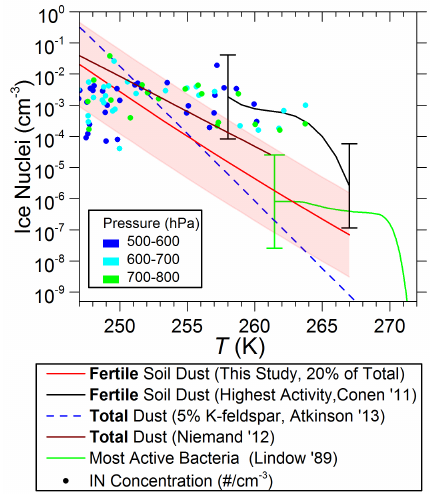
Fig. 9. The concentration of immersion mode IN based on mod- elled global mean aerosol concentrations and laboratory-derived ice nucleation efficiencies. Calculation of the IN concentrations is de- tailed in Sect. 4. Aerosol concentrations are taken from Hoose et al. (2010b) at 600hPa, vertical bars represent the range of zonal annual mean particle number concentrations (Hoose et al., 2010b; Murray et al., 2012). For the fertile soil dust IN concentrations (this study and Conen, 2011) it was assumed that the fertile soil dust loading is equivalent to 20% of the total dust emissions; for the bac- teria it was assumed that 1 / 100 airborne bacteria were as efficient as the most active bacterial ice nuclei from Lindow et al. (1978). IN concentrations for the most active fertile soil dust examined by Conen et al. (2011) are indicated (black line). An estimation of the mineral contribution of IN from desert dusts and fertile soil dusts (i.e. total) is based upon a 5% K-feldspar content (dashed blue line). We also show the IN concentration predicted by the Niemand et al. (2012) (dark red line) based on the total dust burden and IN num- ber concentrations measured at a variety of different altitudes from DeMott (2010). Data are colour-coded according to the pressure at which the measurements were performed (see